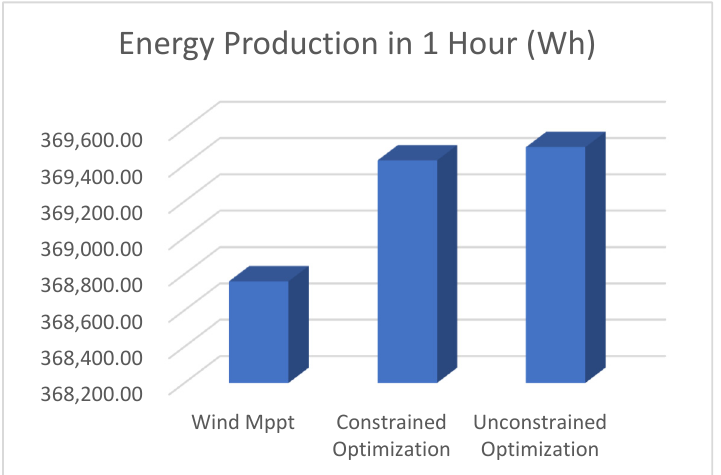
Figure 9. Comparison of energy produced by the HSWT for different optimal control approaches.